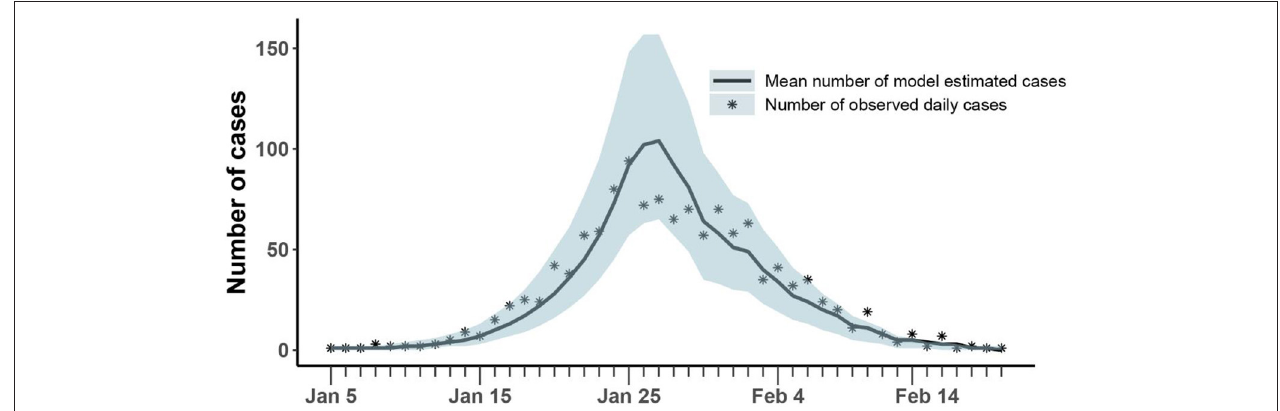
FIGURE 3 | Comparison of the number of cases estimated and observed. The asterisk represents the number of cases with symptoms observed on a daily basis; the curve shows the change in the average number of confirmed symptomatic cases per day estimated by the model. The light blue shade was the 95% confidence interval of the estimation.